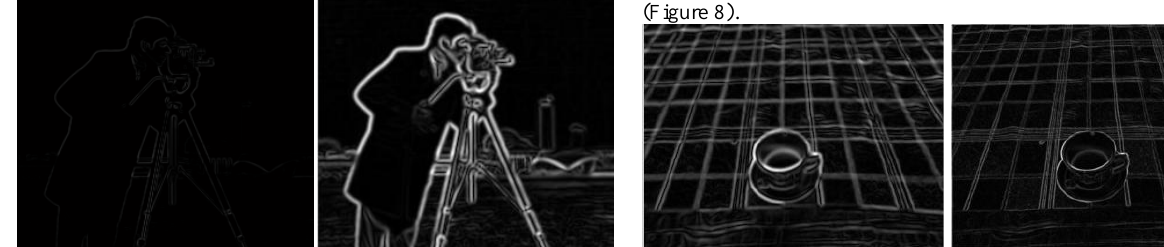
Figure 8. Left: Canny magnitude matrix of image with reduced size to one forth (240*320). Right: Canny magnitude matrix of smoothed image (filter size